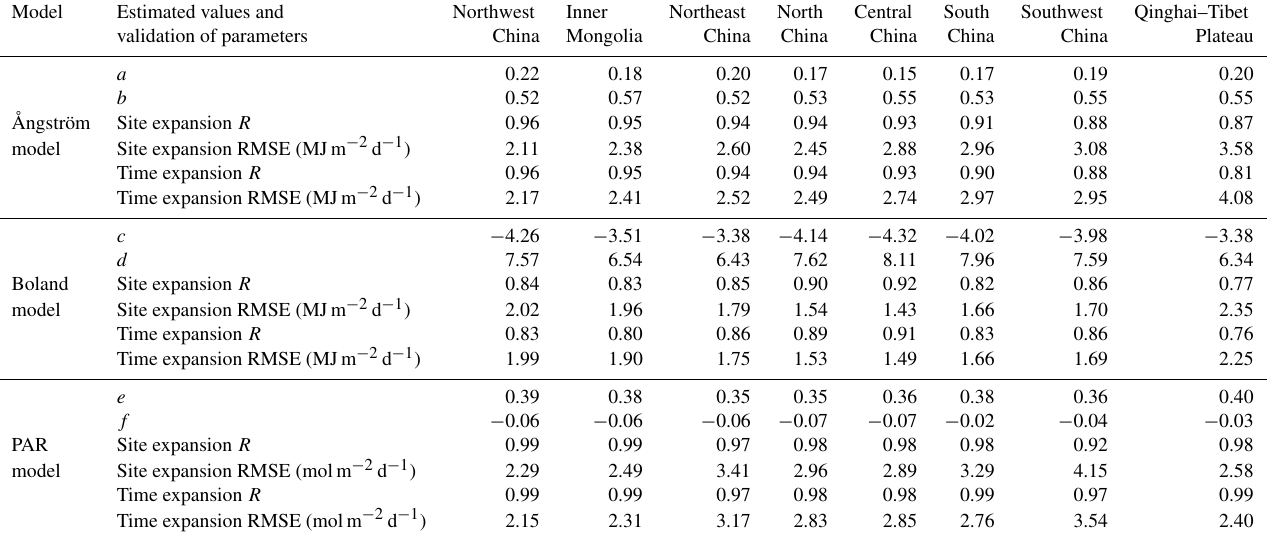
Table 3. Calibration and validation of Ångström, Boland, and PAR models in different regions across China. R and RMSE are the correlation coefficient and the root mean square error,